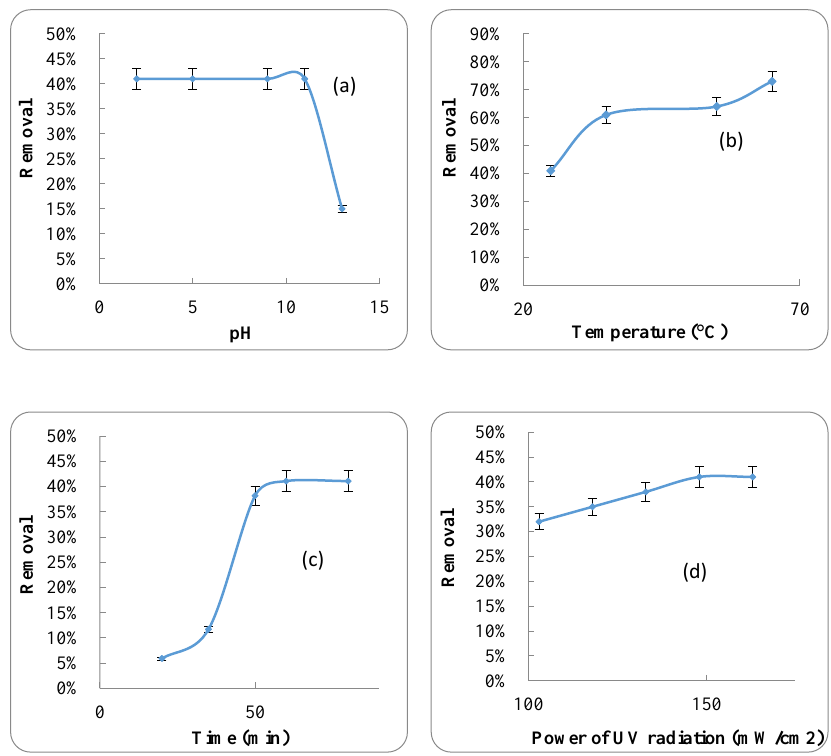
Figure 5. The antibiotic removal by UV radiation ( a ) The effect of different pHs; ( b ) The effect of temperature change; ( c ) The effect of HRT ( d ) The effect of UV radiation power.